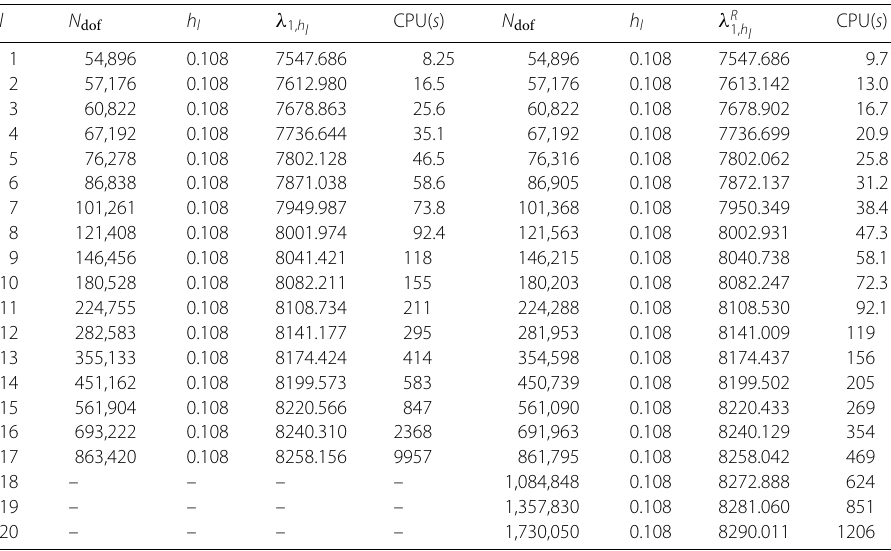
Table 4 The smallest eigenvalue solved by Algorithm 1 and Algorithm